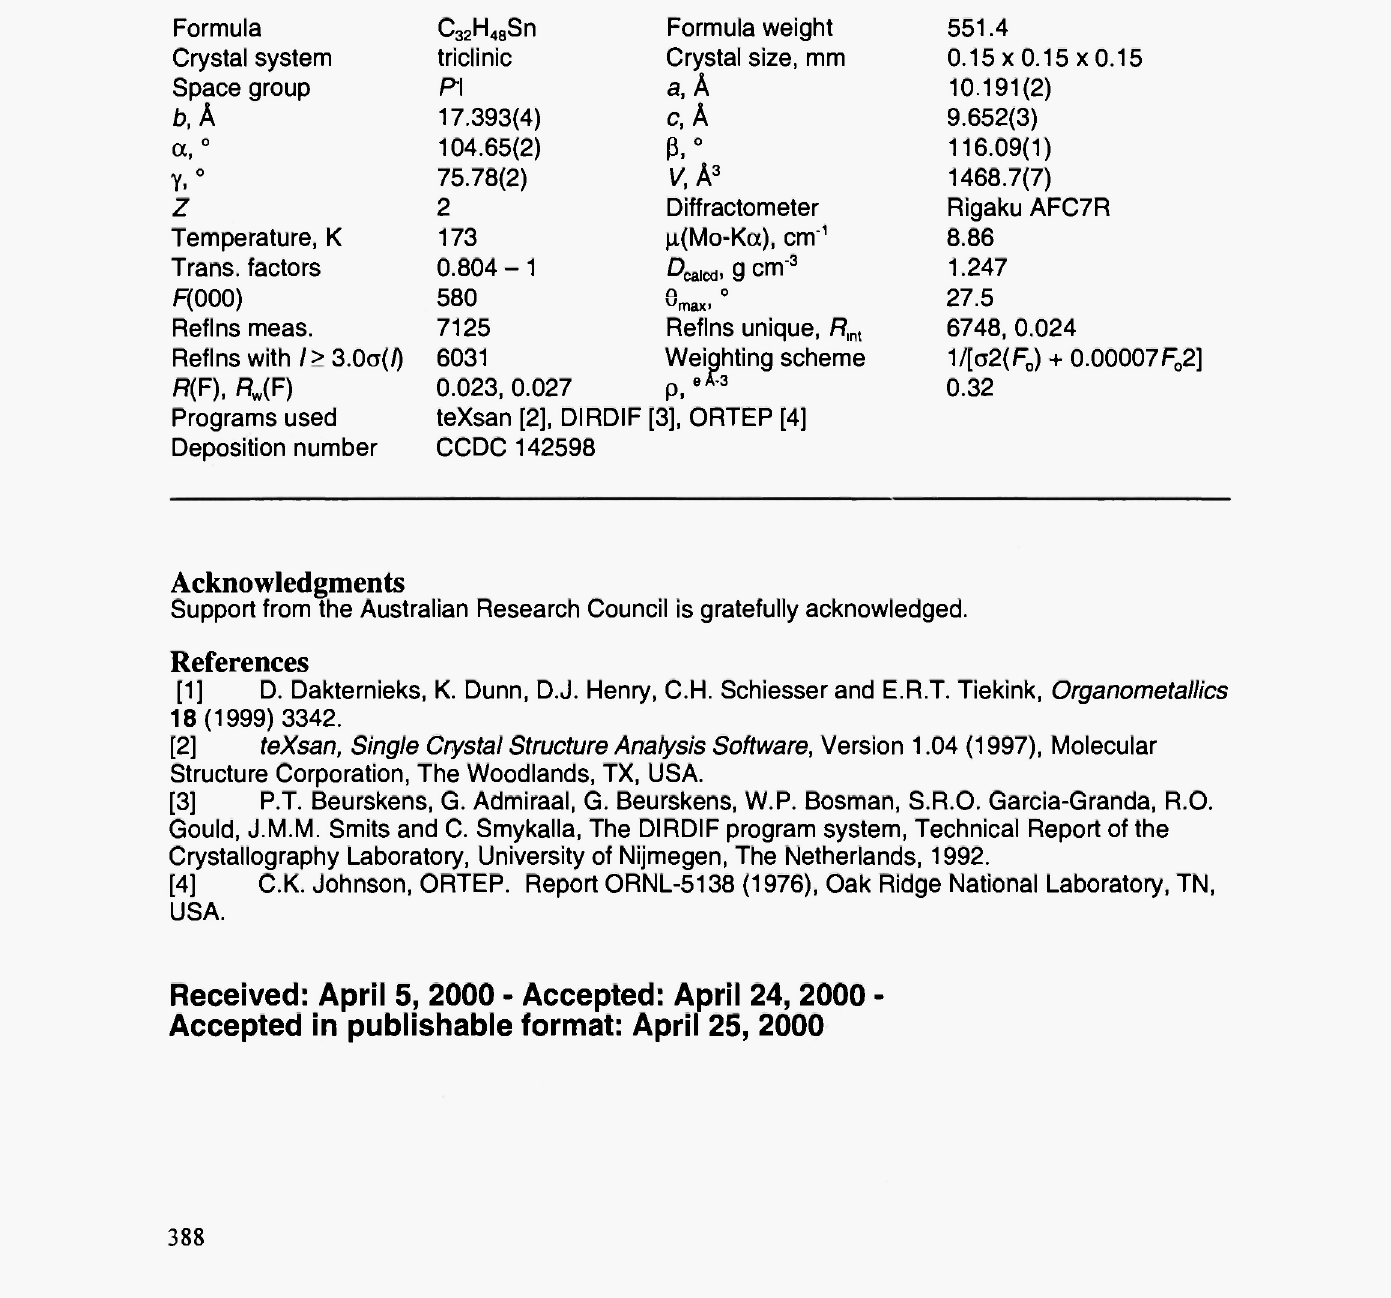
Table 1. Crystal data for [Men 2 Ph 2